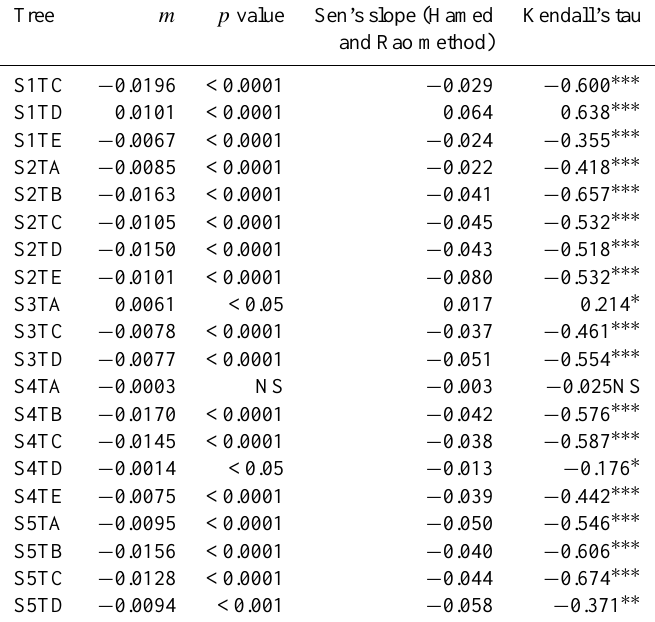
Table 2. Slope based on simple linear regression ( m ), Sen’s slope and Kendall’s tau value based on Mann–Kendall trend test for each tree. The Hamed and Rao method takes into account autocorrelation and adjusts the Sen’s slope estimate. Tau values with ∗ indicate p <0.05, ∗∗ p <0.01, and ∗∗∗ p <0.0001; NS: not